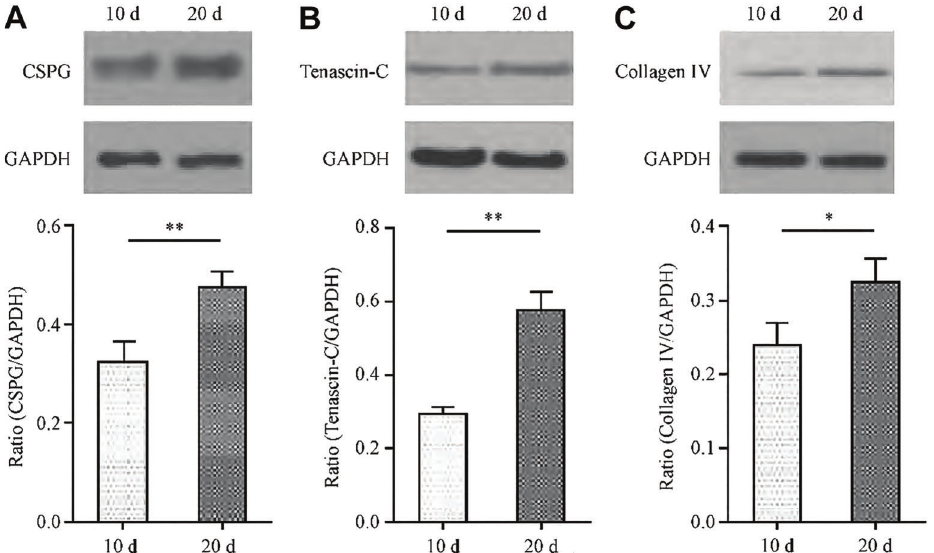
Figure 5. Expression of chondroitin sulfate proteoglycans (CSPGs) in the extracellular matrix in the 10-day and 20-day glioma models by western blotting. A , CSPGs in the 10-day (n=6) and 20-day glioma (n=6). B , tenascin C in the two-stage models. C , collagen IV in the two-stage models. Data are reported as means ± SD (n=6). **P o 0.01, *P o 0.05 ( t